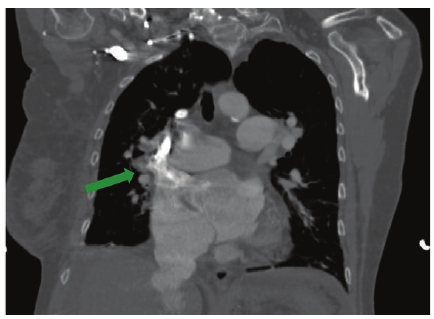
Figure 3: CT-scan showing anomalous right upper pulmonary venous return to superior vena cava (green arrow).